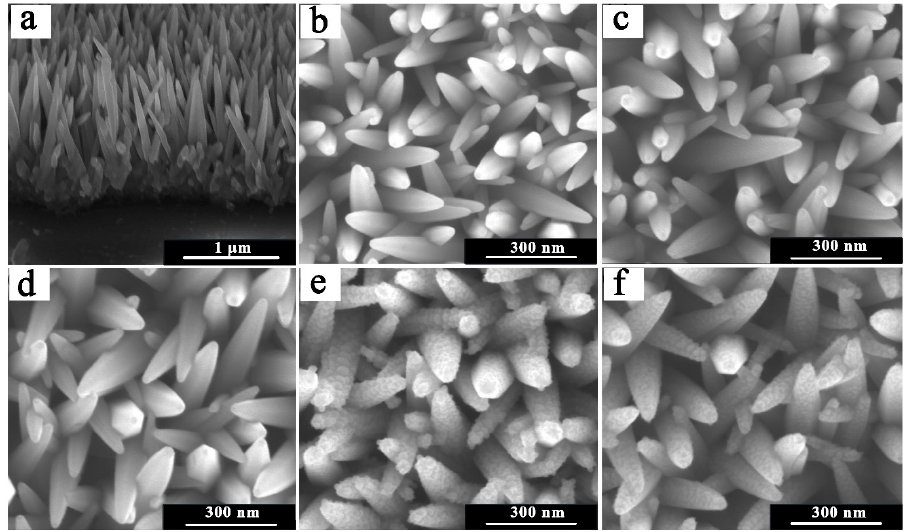
Figure 2. SEM images of the ZnO NRs on the sensor substrate: ( a , b ) pristine ZnO NRs at ( a ) cross-section and ( b ) top view; ( c ) ZnO/Au(1) NRs; ( d ) ZnO/Au(2) NRs; ( e ) ZnO/SnO 2 (1) NRs; ( f ) ZnO/SnO 2 (2) NRs.